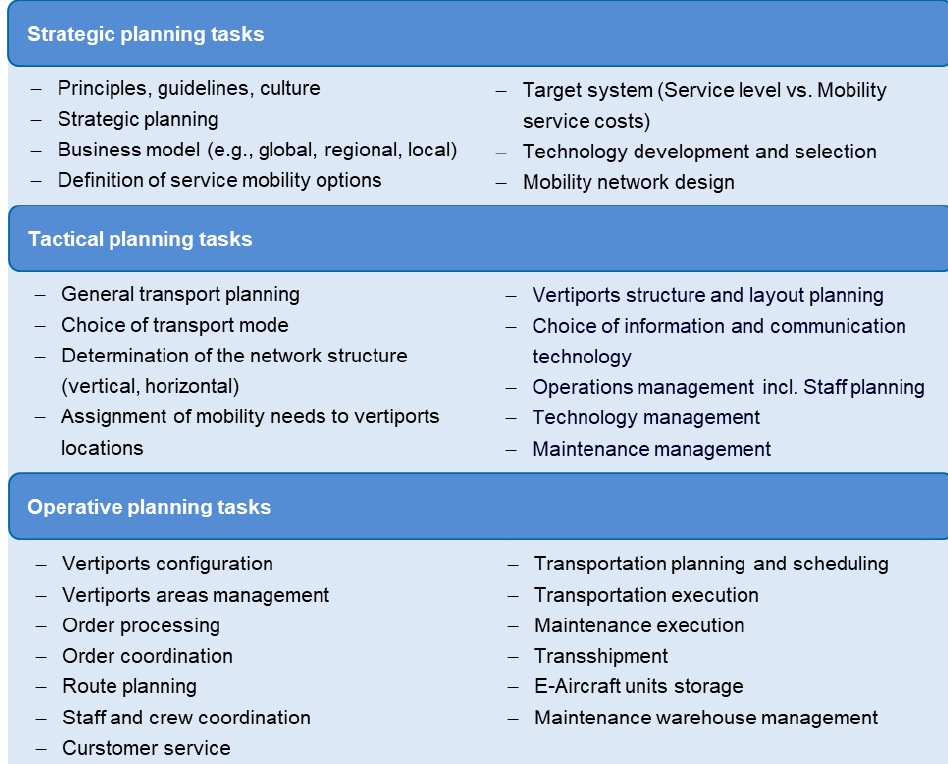
Figure 4. Planning tasks for an aviation mobility supplier.